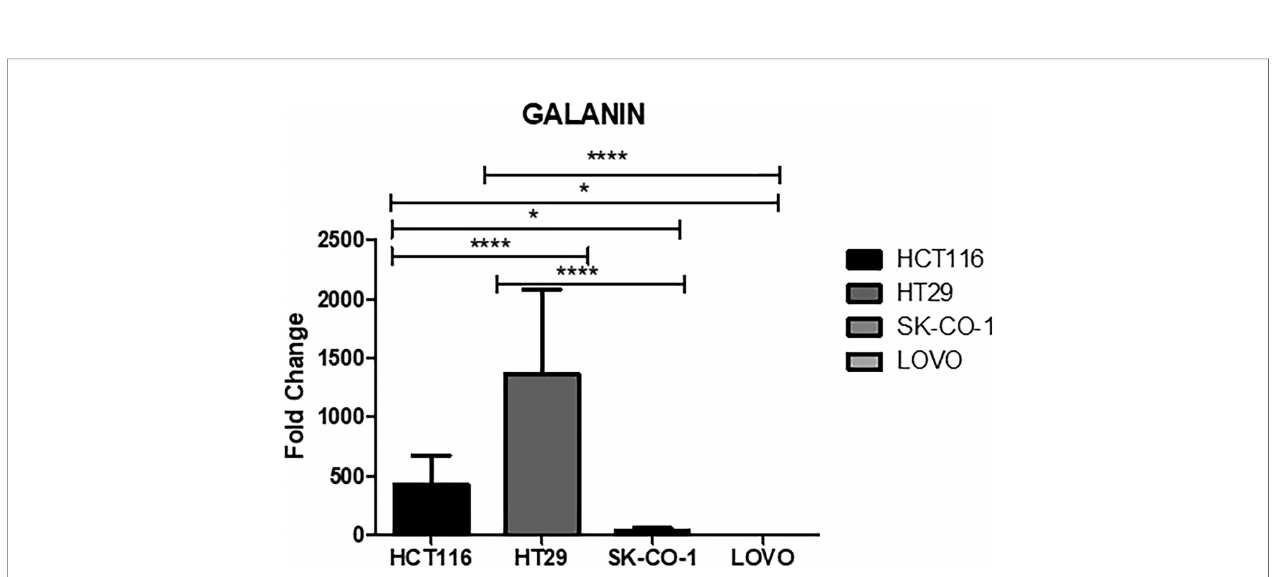
FIGURE 5 | Galanin expression in cell lines. Metastatic cell lines; LoVo and SK-Co-1 showed signi fi cantly lower expression of galanin compared to HCT116 and HT29 cell lines. The cells were starved overnight to ensure synchronization. Gene expression in each cell line was normalized to its corresponding non-starved